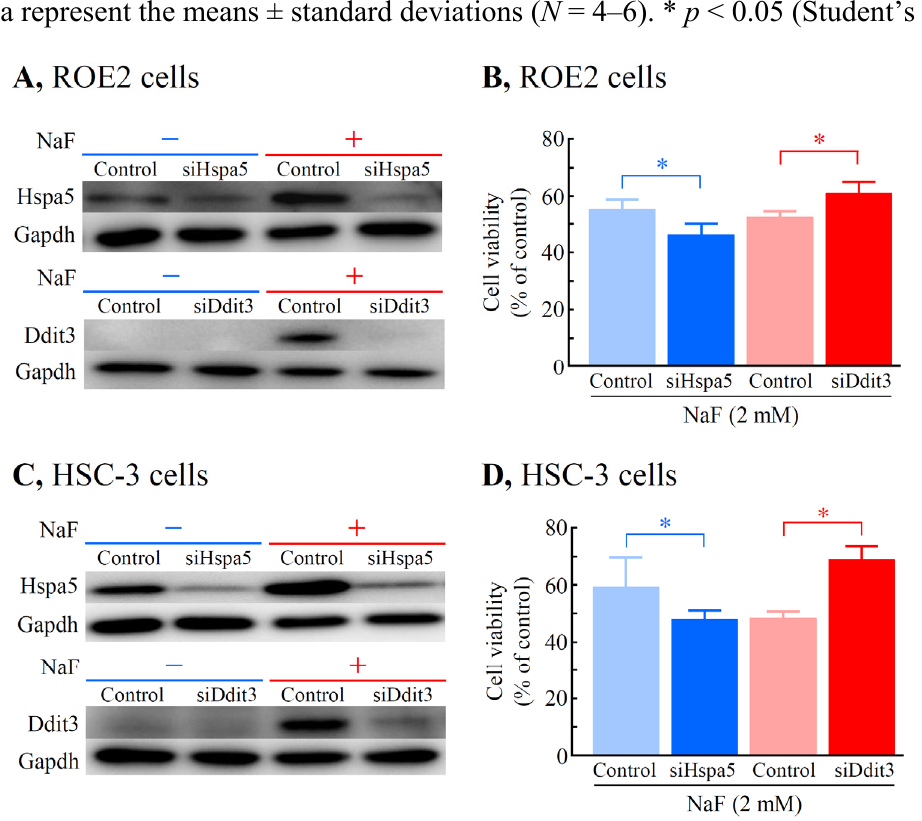
Figure 10. Effects of knockdown of Hspa5 and Ddit3 on the NaF-induced decrease in cell viability in rat oral epithelial ROE2 cells ( A , B ) and human malignant oral epithelial HSC-3 cells ( C , D ). Cells transfected with siRNA for Hspa5 , Ddit3 or luciferase were cultured with or without 2 mM of NaF for 24 h. Luciferase siRNA-treated cells served as a control. ( A , C ) Western blot analysis was performed with the specific primary antibodies for Hspa5 and Ddit3. Gapdh was used as a loading control; and ( B , D ) Cell viability was monitored using a WST-8 assay. Cell viability in the cells treated with 0 mM NaF was taken as 100%. The data represent the means ± standard deviations ( N = 4–6). * p < 0.05 (Student’s t